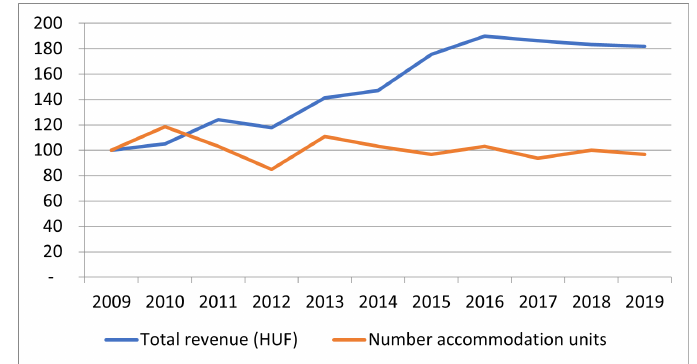
Figure 5: Employee spending in Veszpr´em